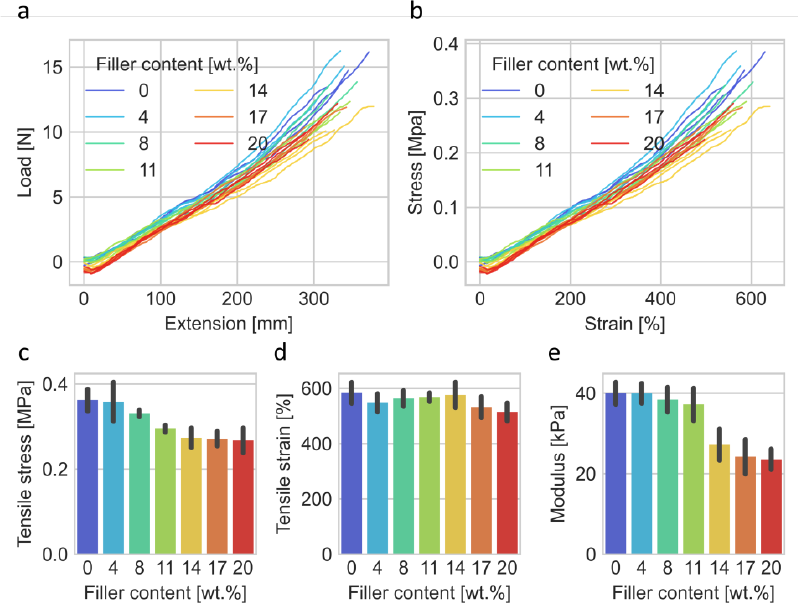
Figure 3. Mechanical properties (tensile test) of the silicone/ethanol composite material with various diamond nanoparticles-based filler concentrations (0 wt.%, 4 wt.%, 8 wt.%, 11 wt.%, 14 wt.%, 17 wt.%, and 20 wt.%): ( a ) extension vs. load; ( b ) strain vs. stress; ( c ) stress at failure; ( d ) strain at failure; ( e ) modulus at 100% elongation.